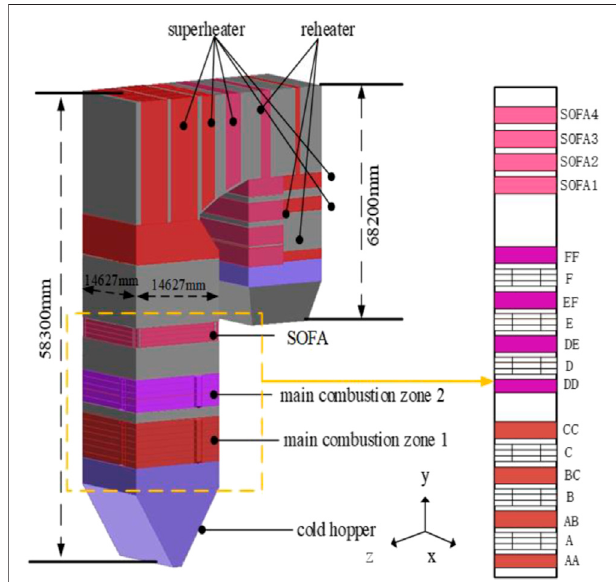
FIGURE 1 | Schematic structure and burner arrangement of the studied 350 MW boiler. (A) Boiler structure (B) Arrangement of the burner and the secondary wind.